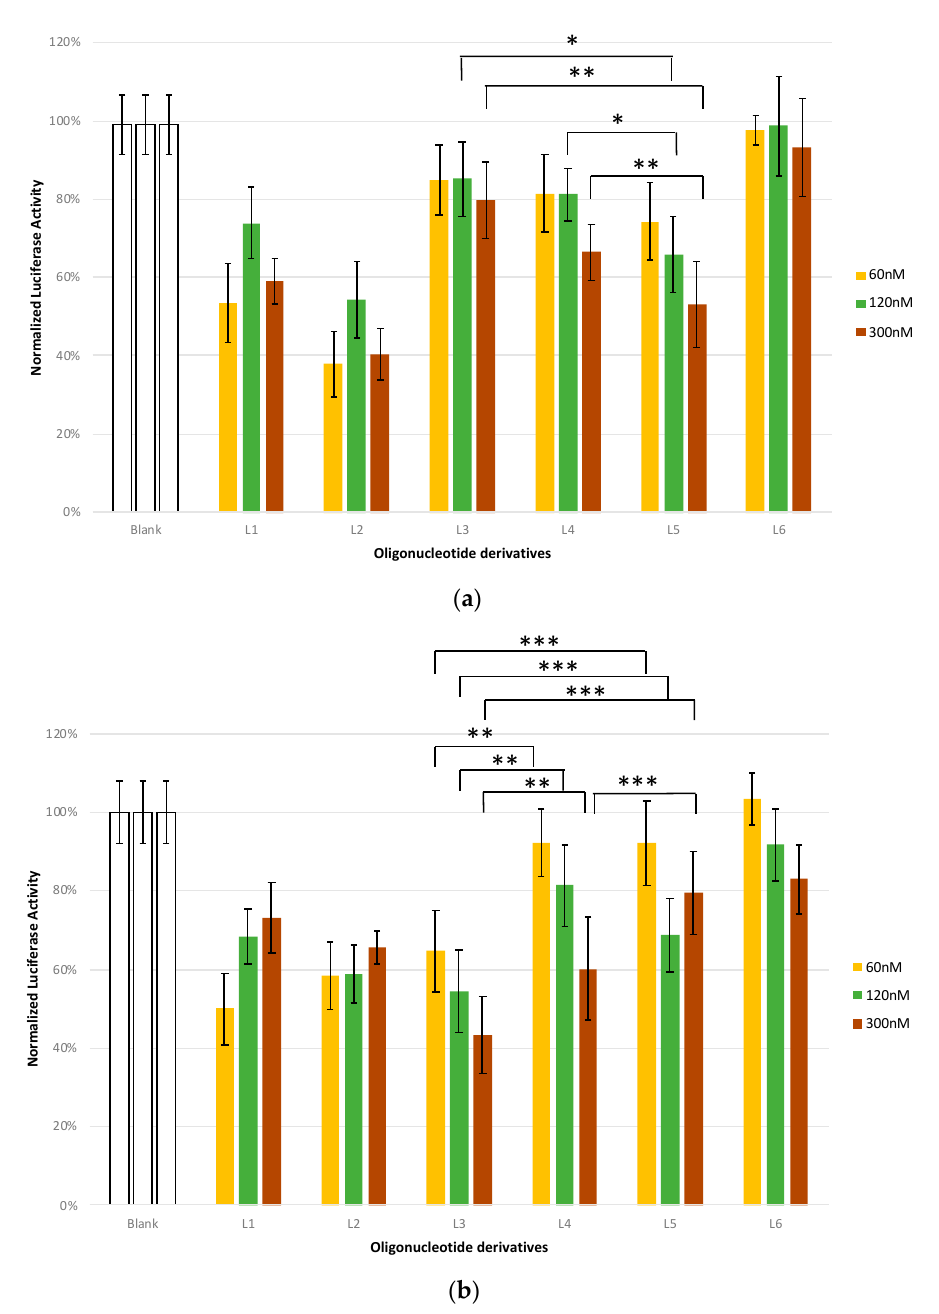
Figure 7. Luciferase inhibitory assay of [L1–L5] in HeLa ( a ) and HepG2 ( b ) cell lines, using L6 as a scrambled negative control and L1 (ASO) and L2 (Gapmer) transfected with lipofectamine as the positive control. Oligonucleotides carrying GalNAc are administrated without transfecting agent. * corresponds to t -test results with * p ≤ 0.1, ** p ≤ 0.05, *** p ≤ 0.01 significantly different within each indicated pair.